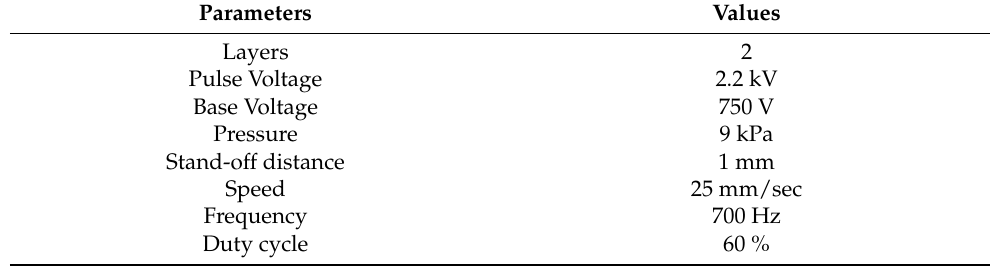
Figure 2. Silver nanoparticle ink operating envelope for steady cone drop/cone generation. Table 1. Optimized experimental parameters for the EHD printing of silver nanoparticle ink.